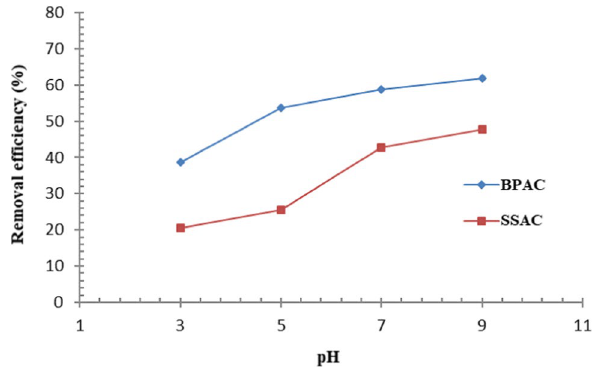
Fig. 5 The effect of pH parameter on the dye removal efficiency of BB41 Fig. 6 The effect of the amount of adsorbent on the dye removal efficiency of